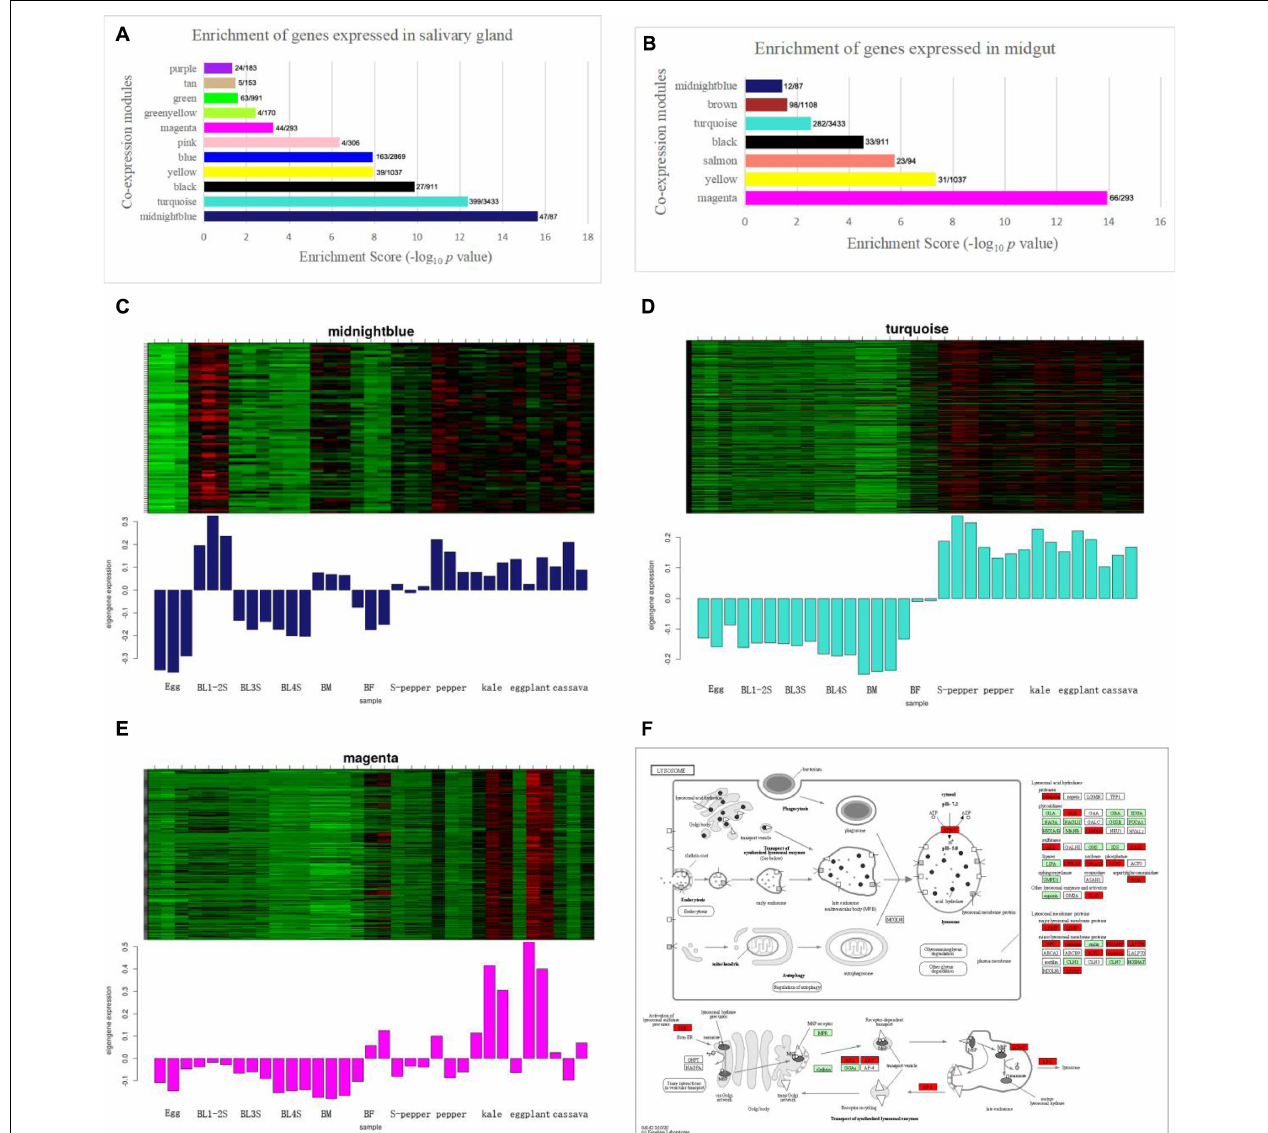
FIGURE 2 | The host plant selection-related module of whitefly is performed by WGCNA. (A) Enrichment scores of genes expressed in salivary gland. The x / y values above the bars indicate gene numbers in the enriched category ( x ) and module ( y ). (B) Enrichment scores of genes expressed in midgut. The x / y values above the bars indicate gene numbers in the enriched category ( x ) and module ( y ). (C) The heatmap of expression pattern of genes in midnight blue module enriched in salivary gland. (D) The heatmap of expression pattern of genes in turquoise module enriched in salivary gland. (E) The heatmap of expression pattern of genes in magenta module enriched in midgut. (F) The KEGG enrichment of Lysosome in turquoise module with the P -Value of